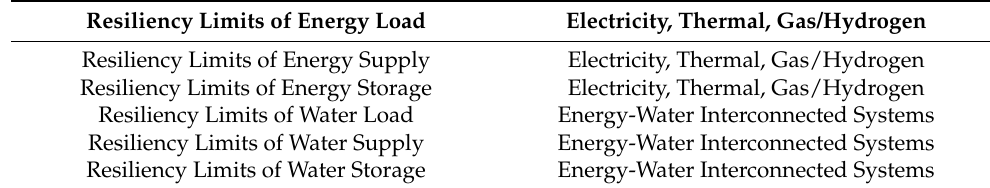
Table 1. Resiliency limits dependencies.